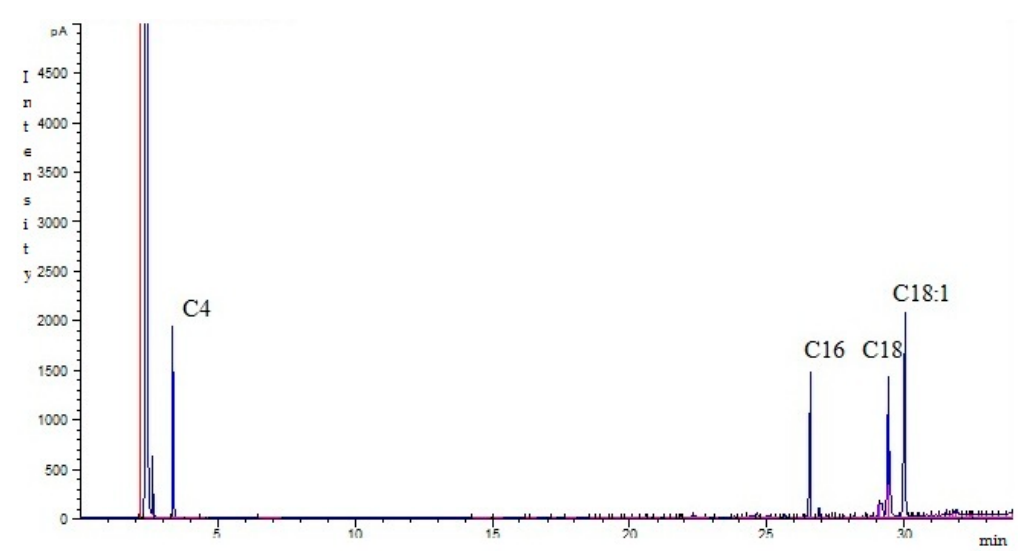
Figure 3. A typical gas chromatography-flame ionization detector (GC-FID) chromatogram indicating the fatty acids of PPSO.